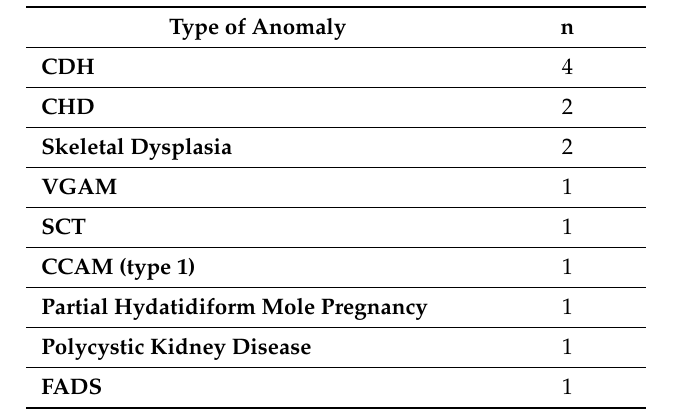
Figure 1. Study population flowchart. NIHF, nonimmune hydrops fetalis; MCDA, monochorionic diamniotic twin pregnancy. Table 1. Structural anomalies detected via ultrasound in foetuses presenting with hydrops.